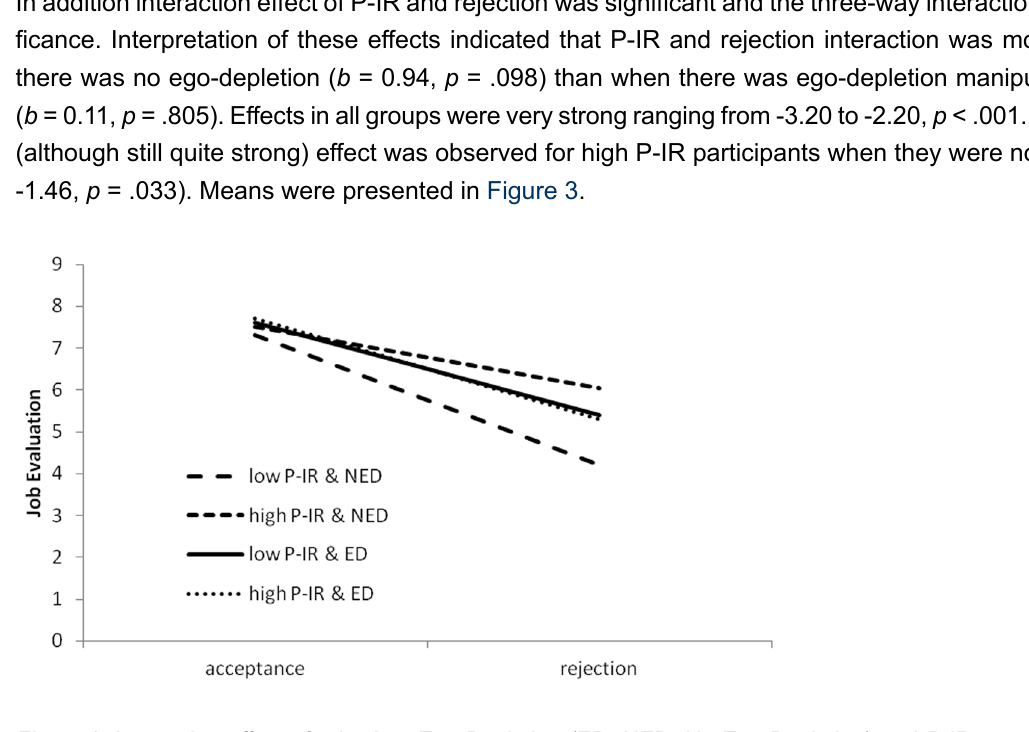
Figure 3. Interaction effect of rejection, Ego-Depletion (ED; NED, No Ego-Depletion) and P-IR on aggression. Slopes are plotted at the ±1